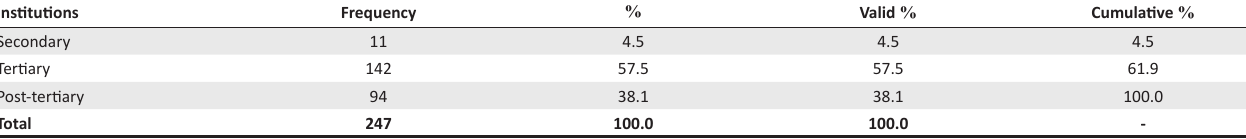
TABLE 2: The statistics on respondents’ educational level. Institutions